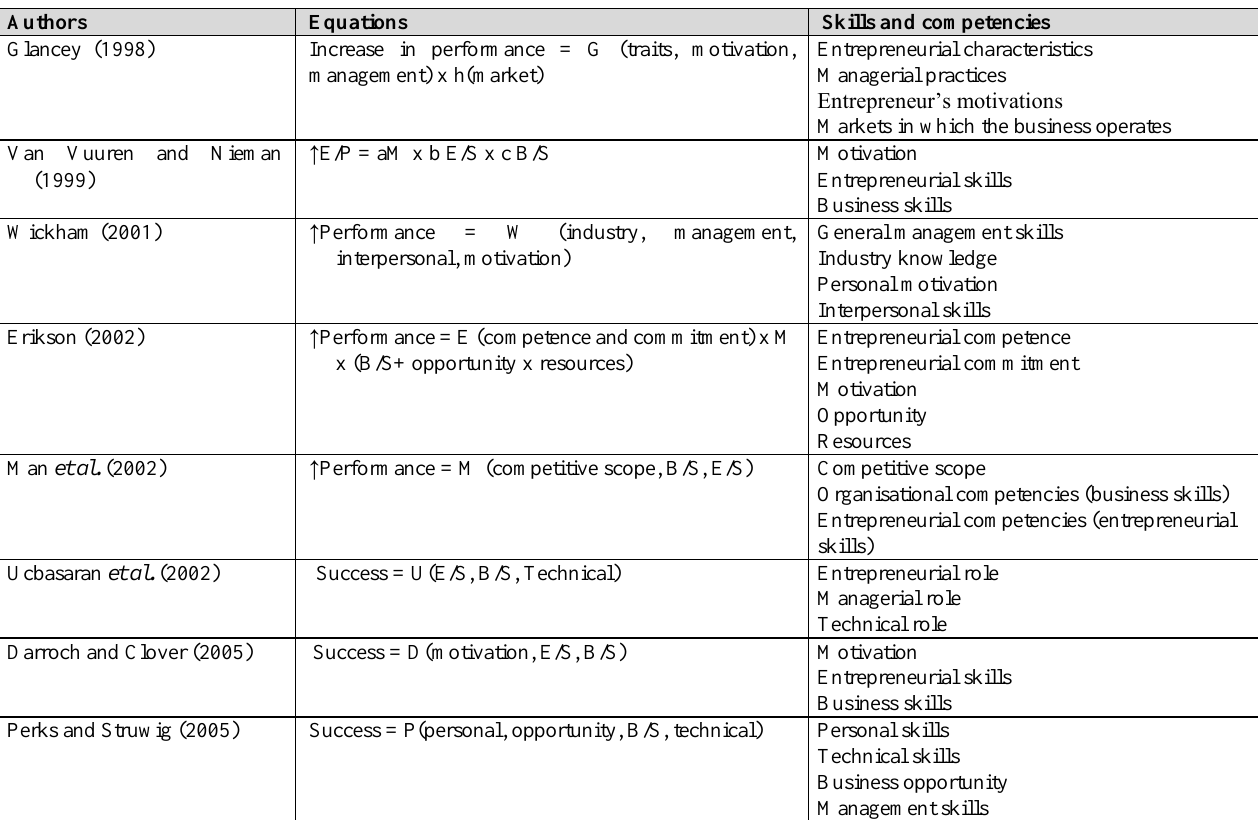
Table 1: Equations of the entrepreneurial performance models